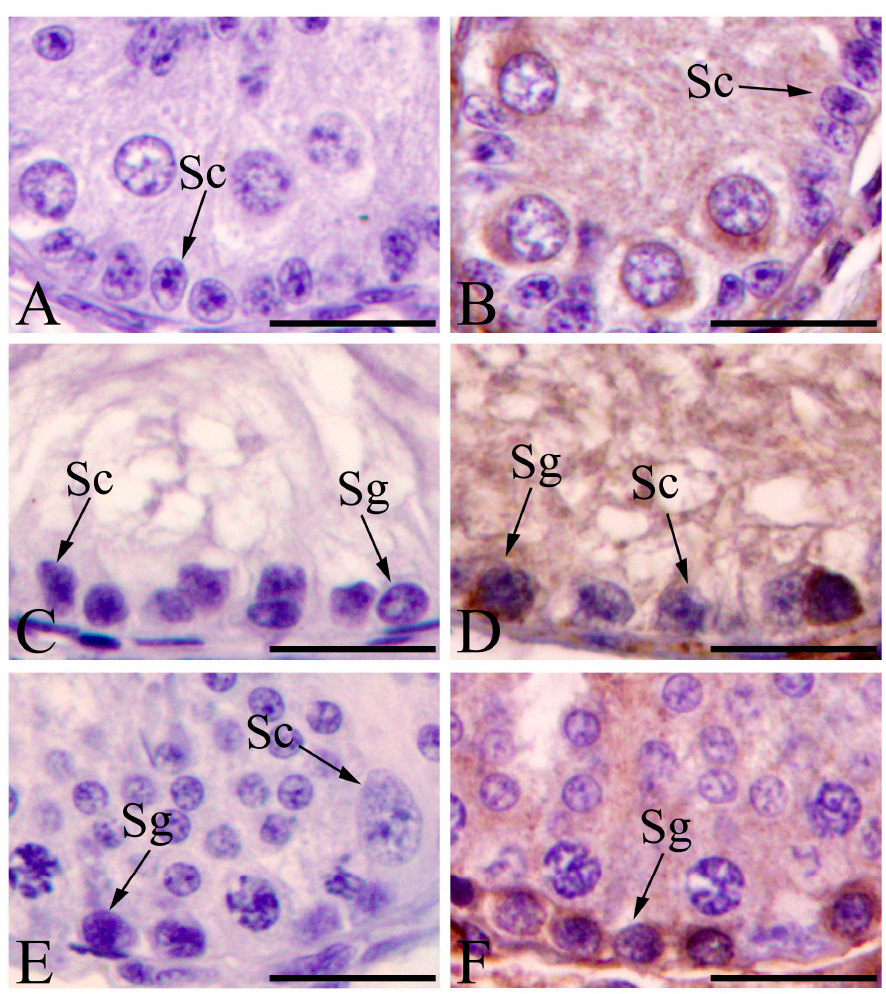
Figure 6. Immunohistochemical staining of LC3 in seminiferous tubules of boar testes. LC3-positive cells in preweaning, cryptorchid, and contrascrotal testes—( B , D , F ), respectively. In the negative control sections of boar testes—( A , C , E )—non-immune rabbit serum was substituted for the primary antibody in the first reaction. Note the lack of immunoreactivity. Sg, spermatogonia; Sc, Sertoli cell. Bar = 25 μ m.